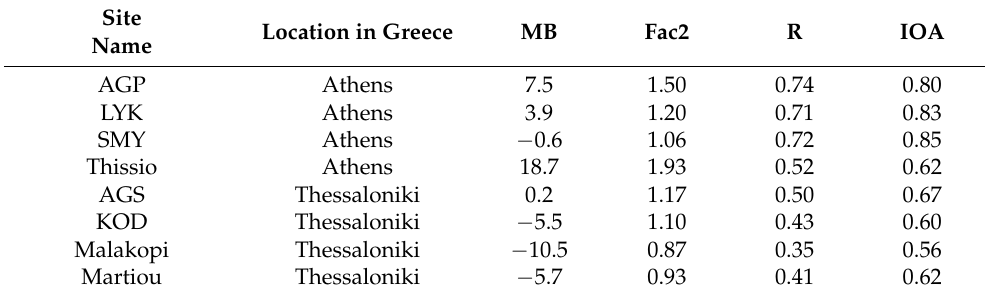
Table 6. Statistical metrics for PM10 mean daily concentrations ( µ g/m 3 ) for each monitoring site over Thessaloniki, Greece (for d03 domain, 2 × 2 km 2 ) and the rest of Greece (for d02 domain, 6 × 6 km 2 ) for the cold period of 2015 (January–April, October–December) for the on-line